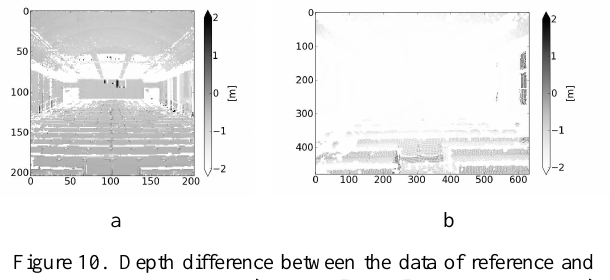
Figure 10. Depth difference between the data of reference and test device: a) PMD [vision] CamCube 2.0, b) Microsoft Kinect.